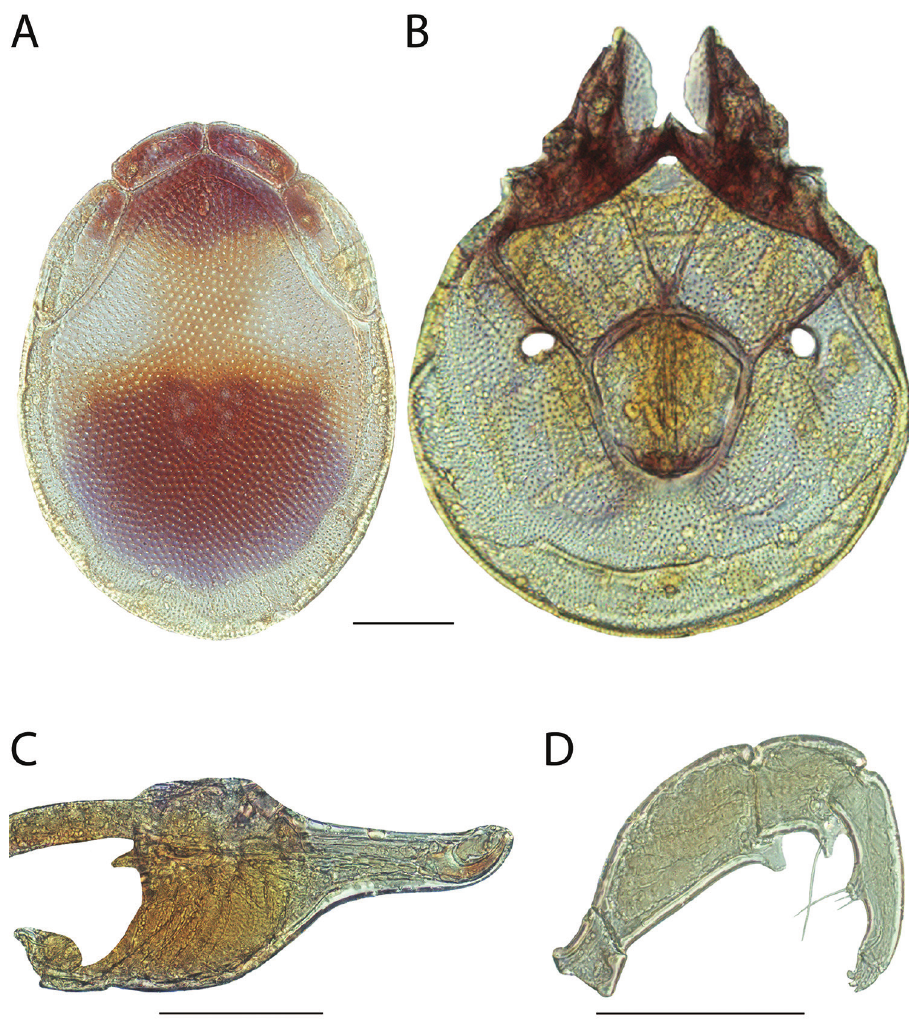
Figure 229. Torrenticola rufoalba female: A dorsal plates B venter (legs removed) C subcapitulum D pe- dipalp (setae not accurately depicted). Scale = 100 µm.